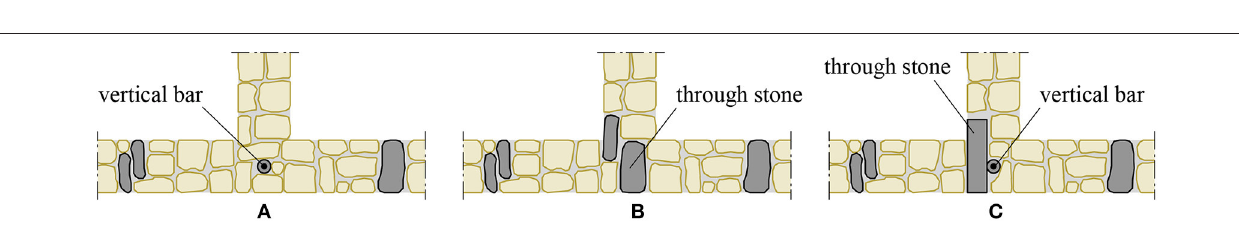
as M15 and M20 or mention that the concrete must have